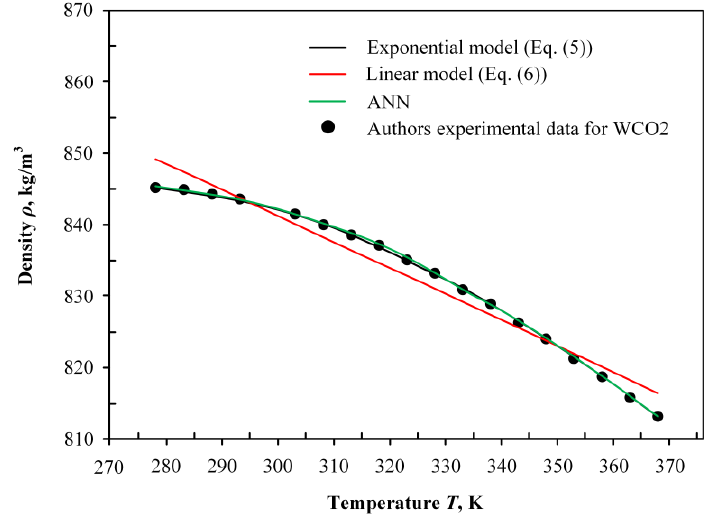
Fig. 5. Variation in density of WCO2 vs.